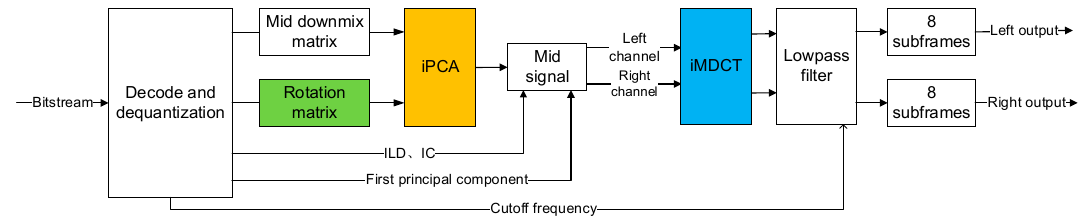
Figure 13. Flowchart of stereo decoder. (MDCT, Modified Discrete Cosine Transform; iPCA, inverse Principle Component Analysis; IC, Interaural Coherence; ILD, Interaural Level Difference).